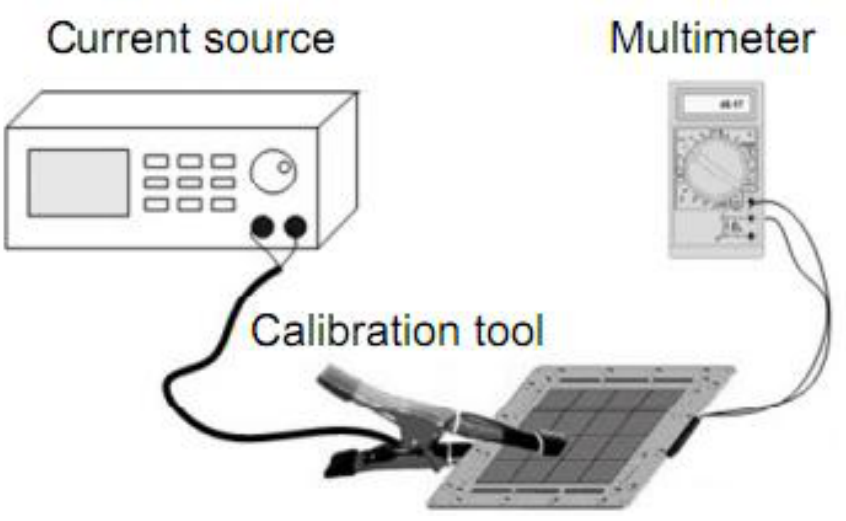
Figure 7. Assembly for determination of calibration